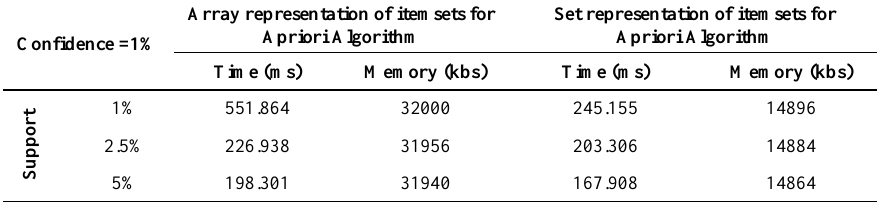
Table 3. Array and set representation of itemsets for Apriori Algorithm with confidence value=2.5% and Support =1, 2.5, and 5%.